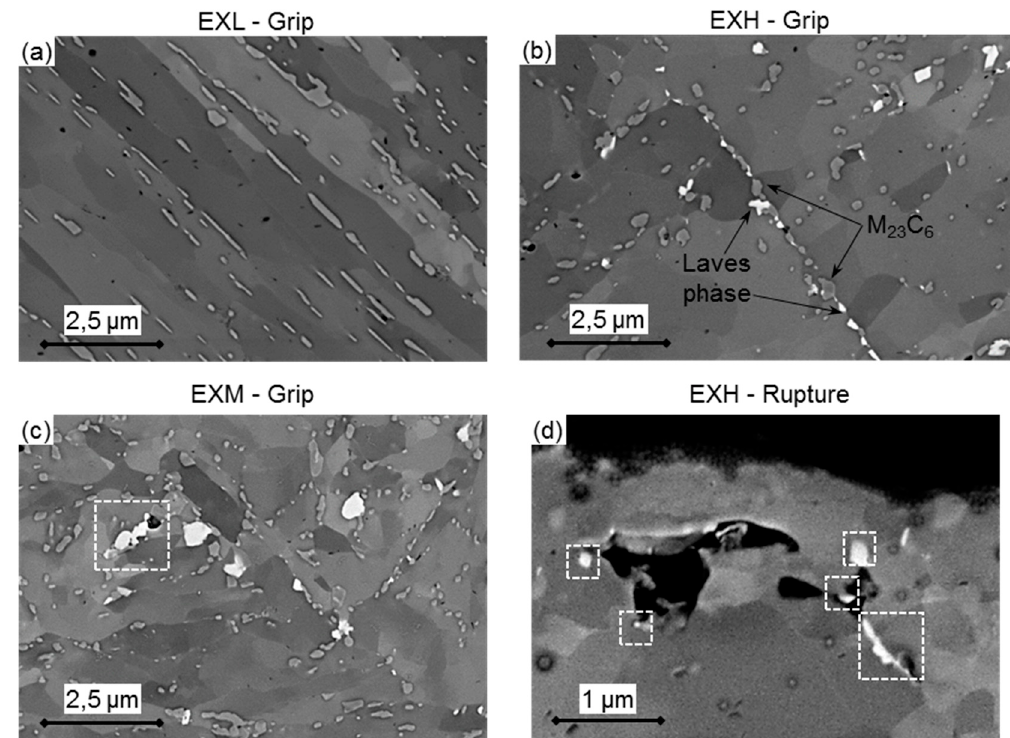
Figure 13. Concentric Backscatter-SEM (CBS-SEM) images of ( a ) EXL, ( b ) EXH and ( c ) EXM grip regions. M 23 C 6 and Laves phase particles can be preliminarily identified in the images based on the local brightness of features. Laves phase particles are found adjacent to large voids near the ( d ) rupture surface of EXH as outlined in white squares.